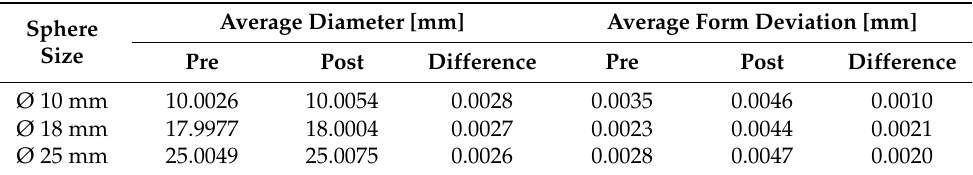
Table 2. Comparison of contact measurement results regarding diameter and form deviation pre- and post-sandblasting.